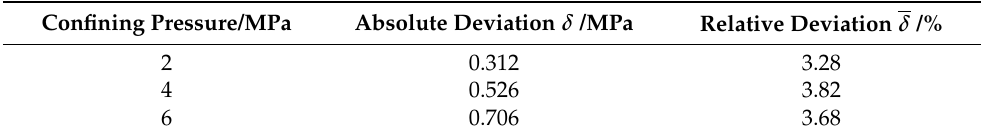
Table 4. Results of model